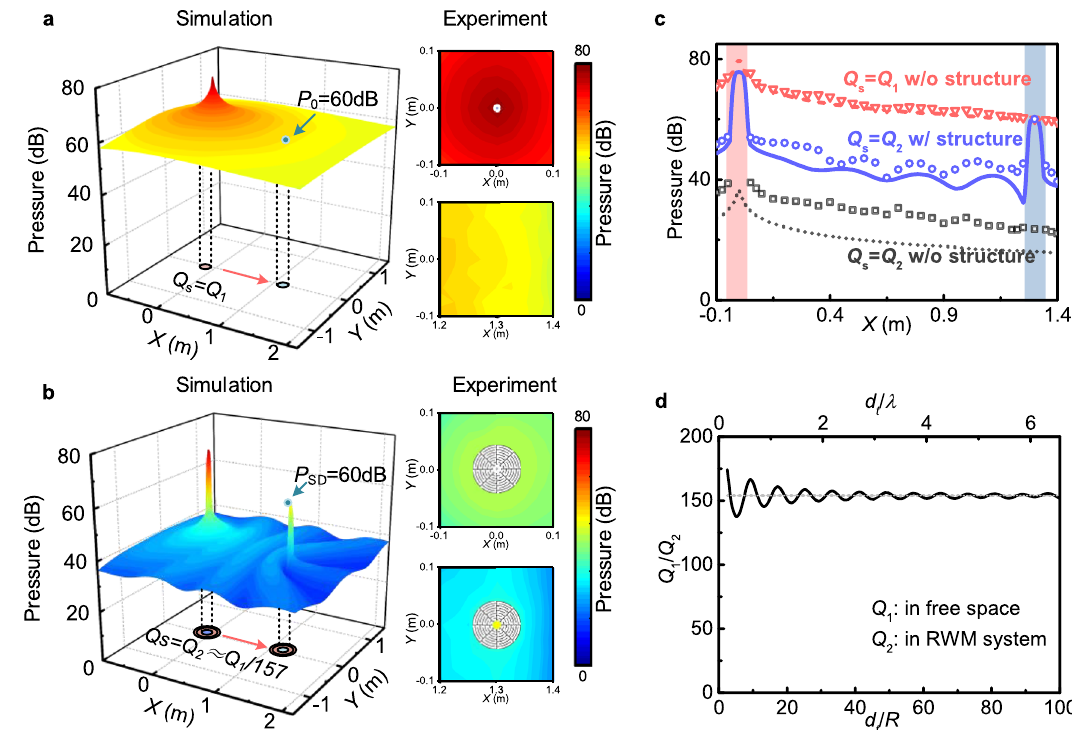
Fig. 4 Whispering weak sound to remote targets. Sound pressure fi elds of ( a ) a strong sound source of intensity Q 1 in free space, and ( b ) a weak source of intensity Q 2 = Q 1 /157 using the proposed system. The detected pressure at the receiving points reaches 60 dB in both cases. The insets in a , b show experimental pressure fi elds around the emitting and receiver sites. c Corresponding pro fi les of sound pressure along x ( m ) for y = 0 in three cases: the strong source Q 1 in free space (red), the weak source Q 2 with the RWM (blue), and a weak source Q 2 in free space for comparison (gray). The curves and symbols denote calculated and measured results, respectively. d The source intensity contrast of Q 1 / Q 2 at different distances to maintain a 60 dB pressure level detected at the receiving point with the RWM and in free